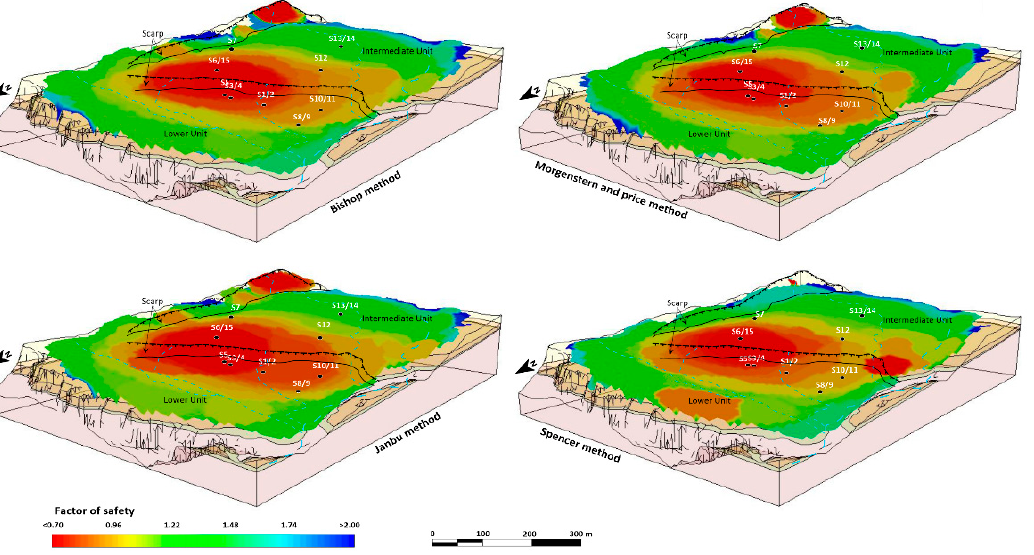
Figure 7. Factor of safety variation map using different three-dimensional limit equilibrium methods: Bishop method, Morgenstern and Price method (GLE), Janbu method and Spencer method.